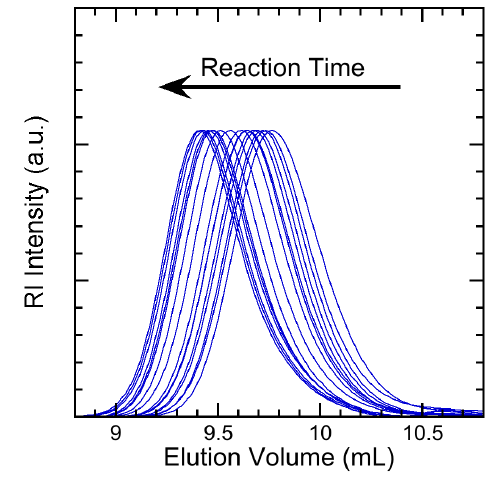
Figure 2. SEC profiles for PMMA-1 vs. time (normalized intensity